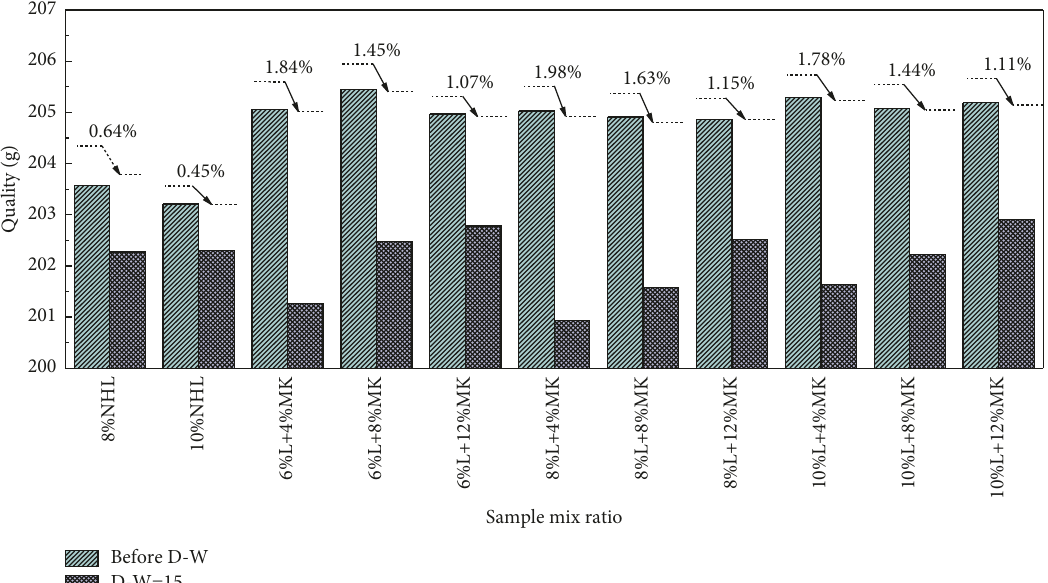
Figure 4: Changes in sample quality before and after dry-wet